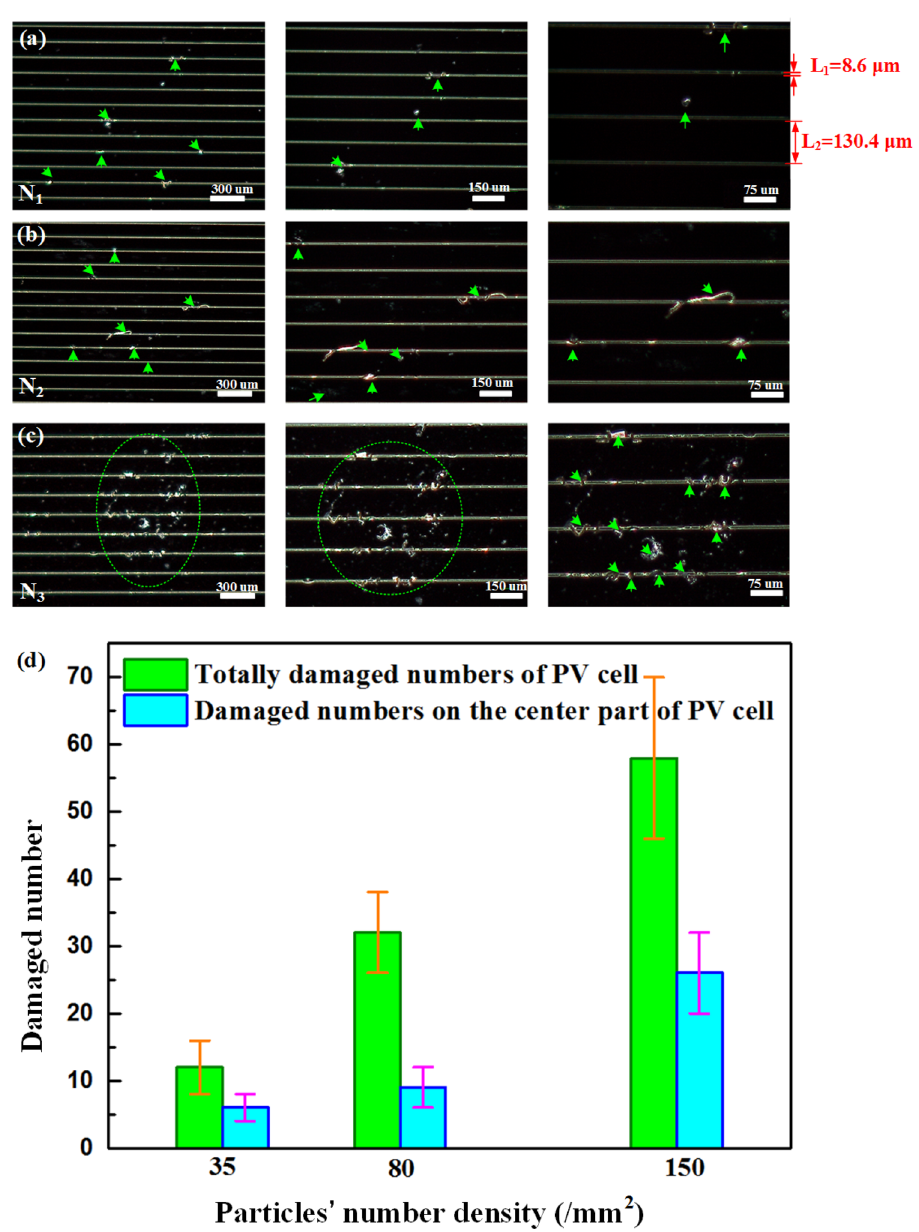
Figure 5. Three damaged patterns of the PV cells impacted by particles with ( a ) low, ( b ) medium, and ( c ) high particles number densities. ( d ) Relationship between damaged number and impact particles’ number